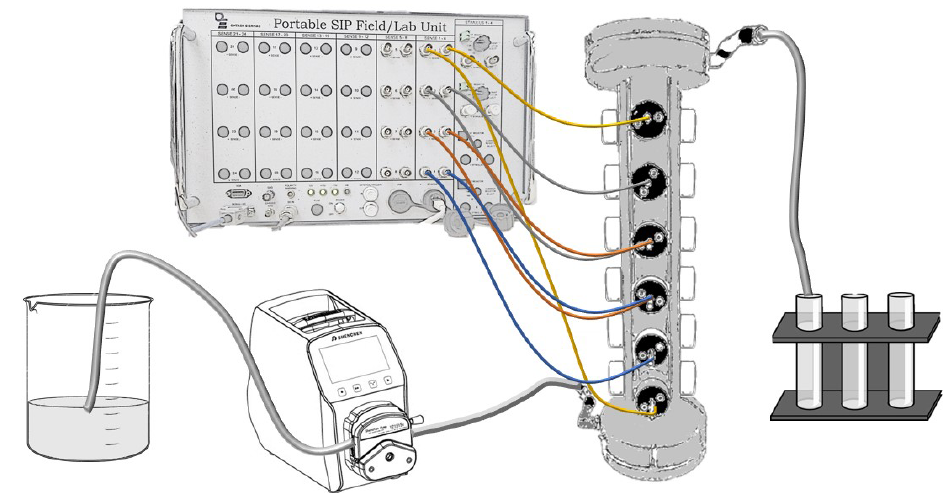
Figure 1. Laboratory setup: the inflow solution is pumped into the column from its bottom, and the outflow is collected in fractions. SIP signal is measured between three sets of potential electrodes: channel 1 (blue), channel 2 (orange) and channel 3 (grey). The current is injected between the top and bottom electrodes (yellow).